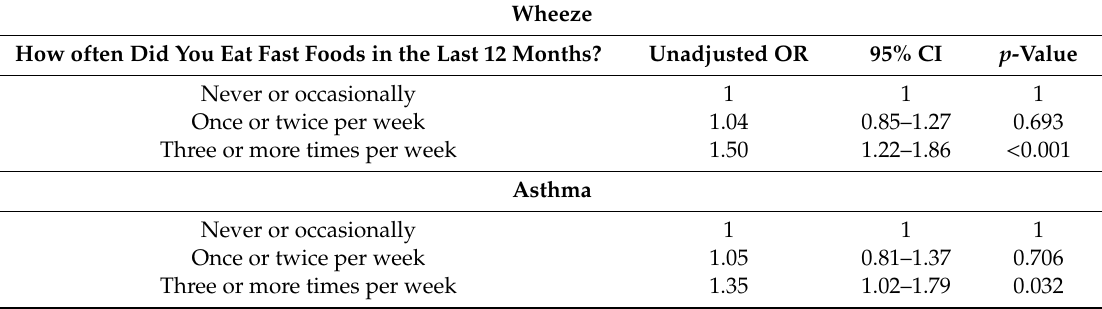
Table 3. Unadjusted odds ratios of wheeze, asthma and fast foods among the study participants ( n = 3641).